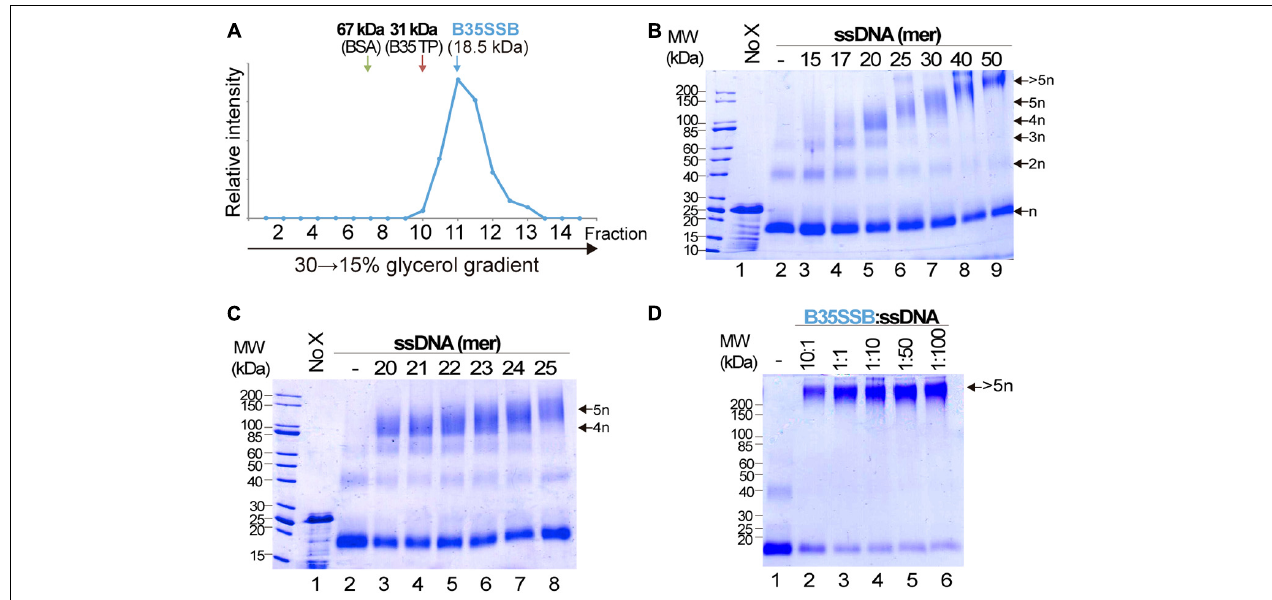
FIGURE 4 | Analysis of B35SSB modularity and cooperativity. (A) Determination of the oligomerization state of B35SSB in solution. Recombinant B35SSB was subjected to sedimentation in 15–30% (w/v) glycerol gradients in the presence of molecular weight markers as indicated. The fractions at which the maximal amount of each protein appears are indicated by arrows. (B) Cross-linking protein interaction analysis using different ssDNA sizes ( Supplementary Table 1 ). B35SSB (1 µ M, equivalent to 2 µ g) was incubated with 165 ng of the indicated oligonucleotides. After glutaraldehyde cross-linking, total protein was precipitated and analyzed by SDS-PAGE. The number of SSB cross-linked species is indicated on the right. (C) Determination of the B35SSB minimal binding site by crosslinking assays. (D) Effect of B35SSB:ssDNA ratio in ssDNA-SSB binding. Assays contained 1 µ g B35SSB and increasing amounts of the 50-mer oligonucleotide to obtain the indicated protein:DNA ratio. See Methods for details. MW, molecular weight; No X and dash (–) stand for no crosslinker and no ssDNA lanes,